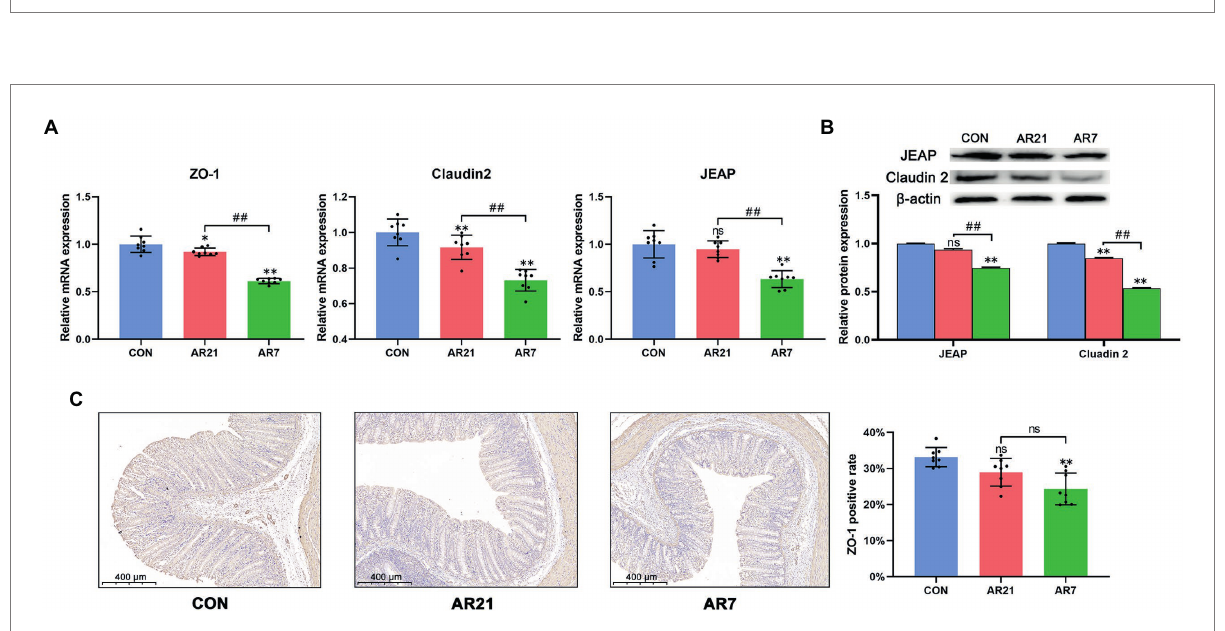
FIGURE 5 Effects of artificial rearing on the tight junction proteins in piglet colon. (A) Relative mRNA expression of tight junction proteins. (B) Relative protein expression of tight junction proteins. (C) ZO-1 positive cells by IHC staining. Data are presented with mean ± SD. ns p > 0.05; * p < 0.05 versus the CON group; ** p < 0.01 versus the CON group; ## p < 0.01 versus the AR21 group. n = 8